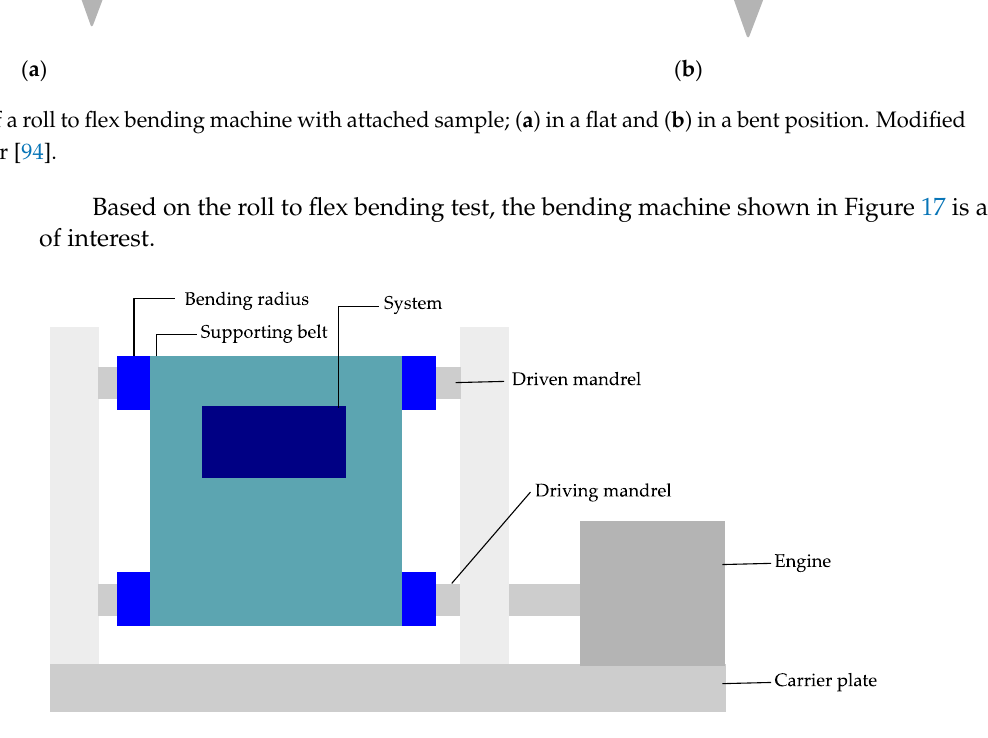
Figure 17. A cyclic bending tester with roll to flex method. Modified and freely sketched after [103].